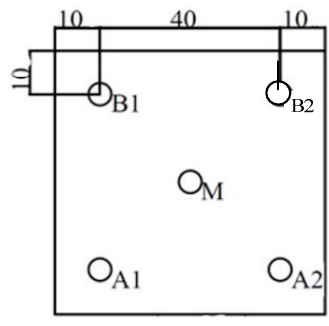
Figure 3. Location of the measuring points during particle measurements.